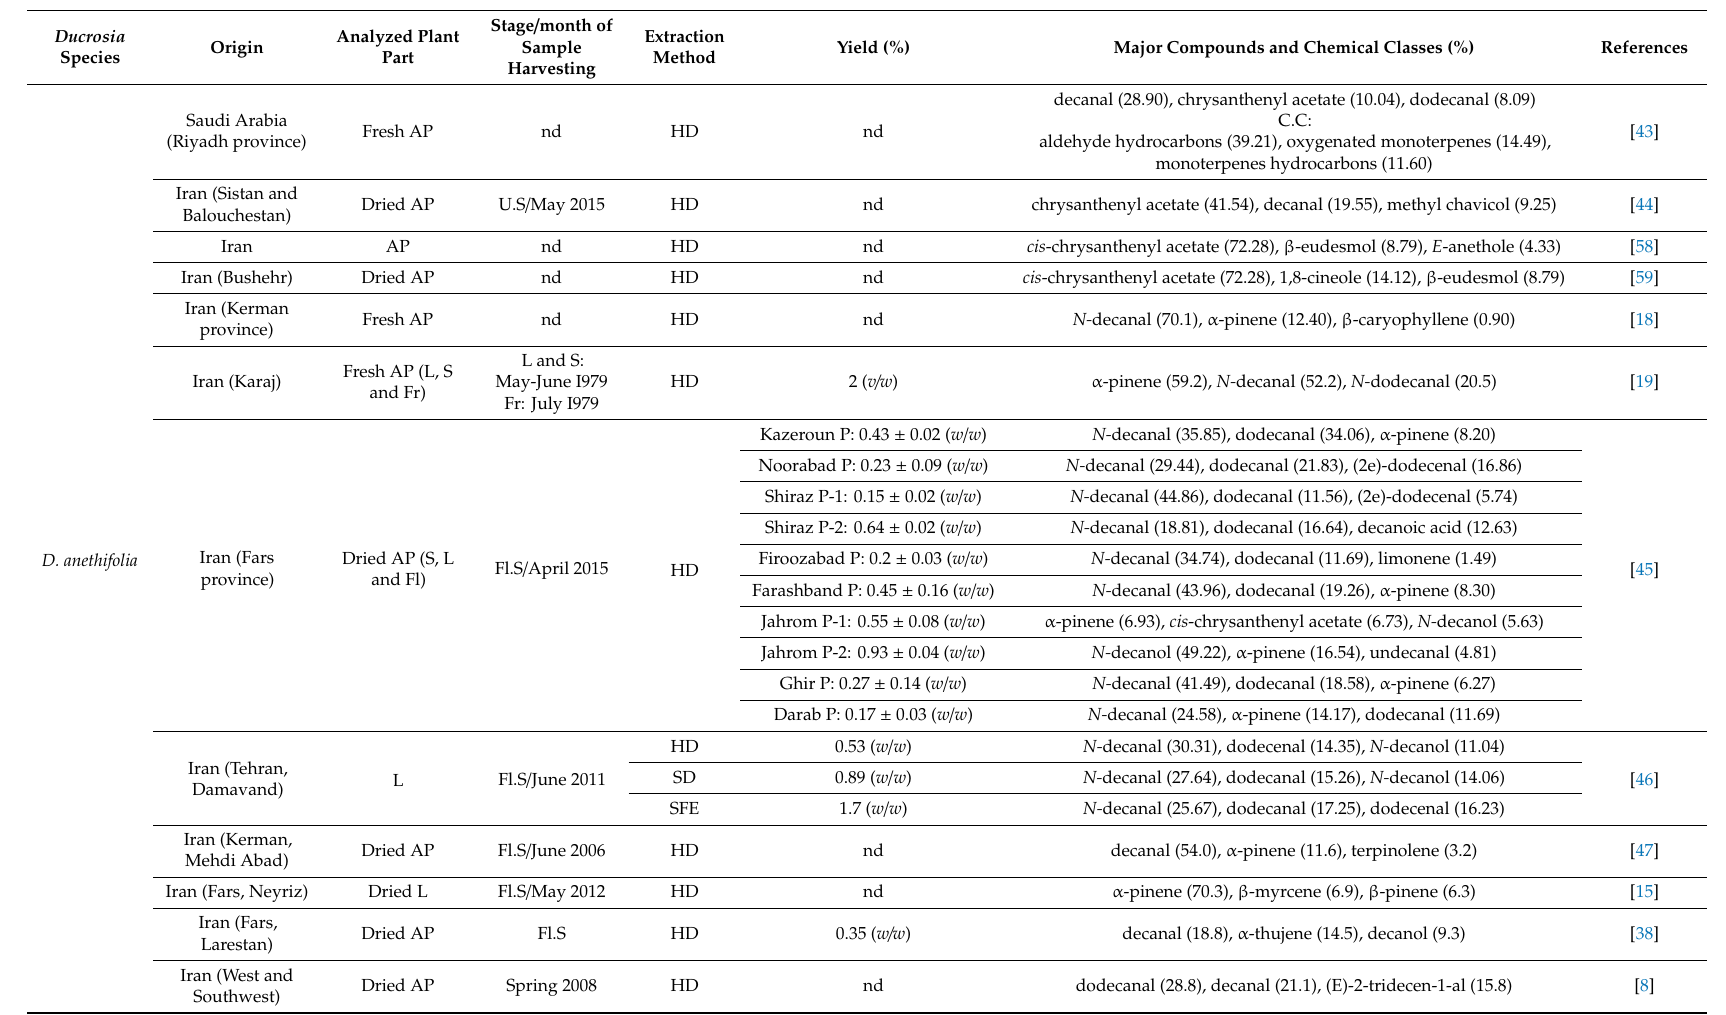
Table 3. Volatile compositions characterized in Ducrosia